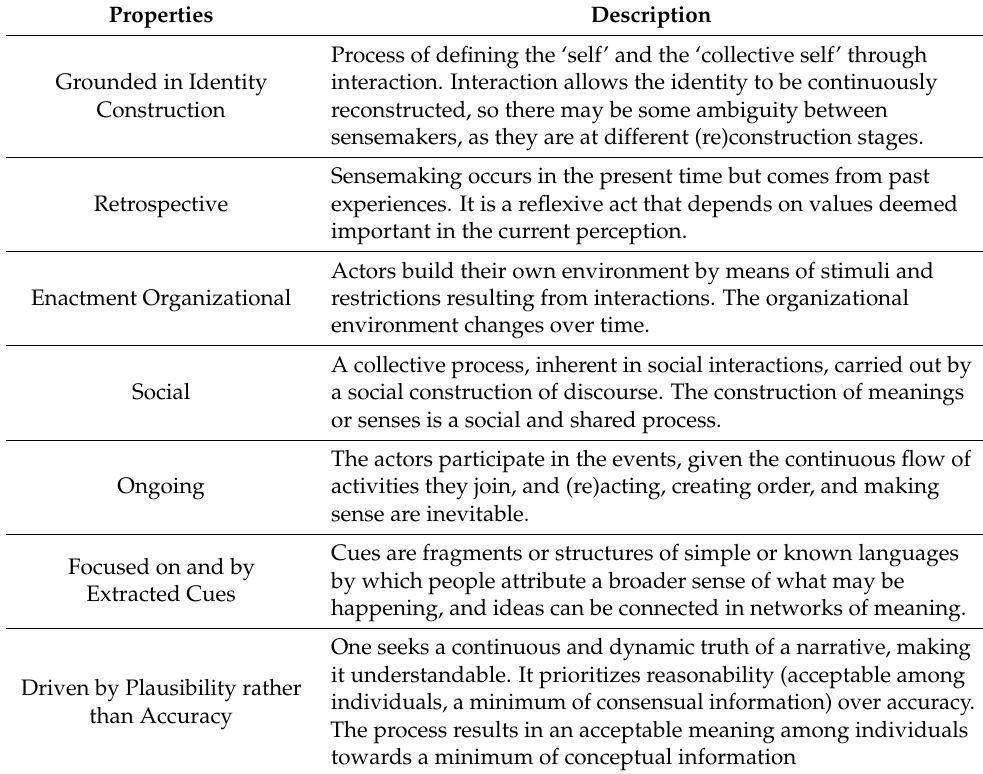
Table 1. Properties of